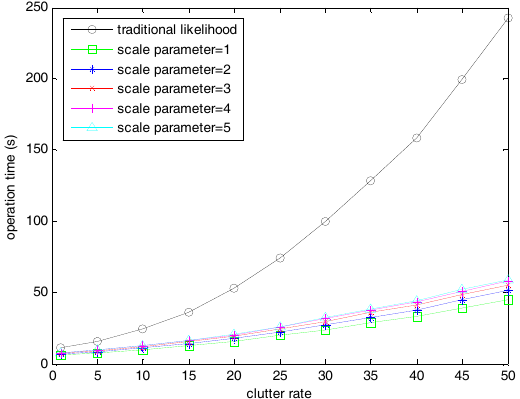
Figure 6. Time consumptions of the SMC adaptive target birth intensity CBMeMBer filter and the fast SMC adaptive target birth intensity CBMeMBer filter with clutter rate varied from 1 to 50.